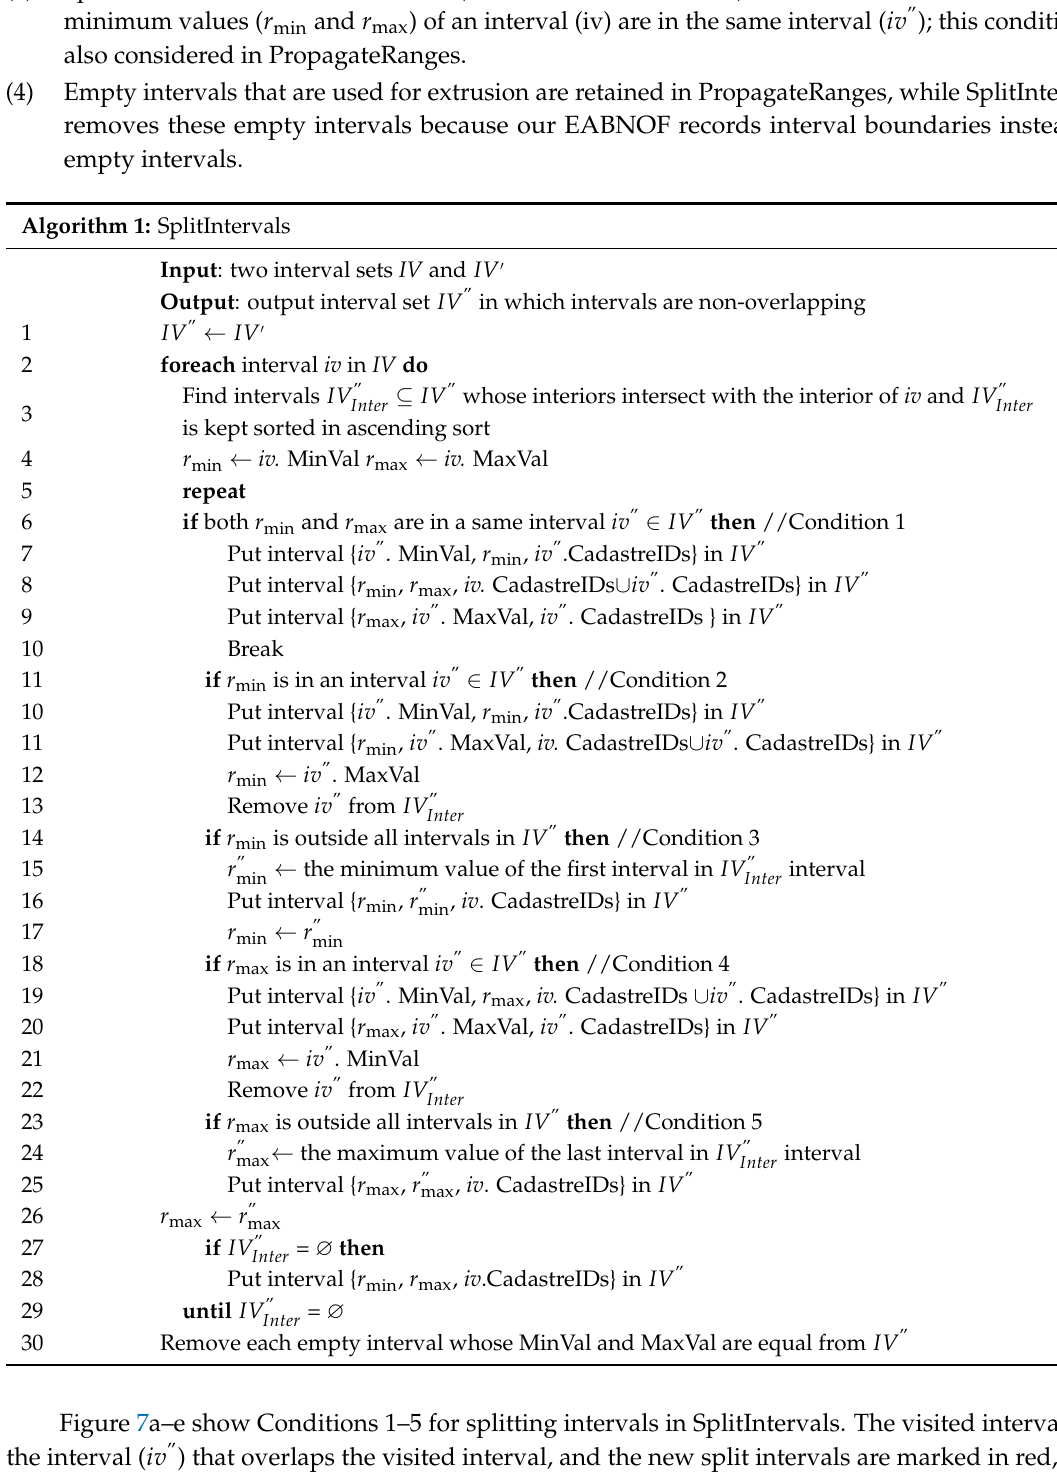
Figure 7a–e show Conditions 1–5 for splitting intervals in SplitIntervals. The visited interval ( iv ), the interval ( iv ” ) that overlaps the visited interval, and the new split intervals are marked in red, blue and purple, respectively. The cadastral IDs that correspond to these intervals are shown as C 1 , C 2 or C 1 ∪ C 2 , and the modifications of the maximum and minimum values are also